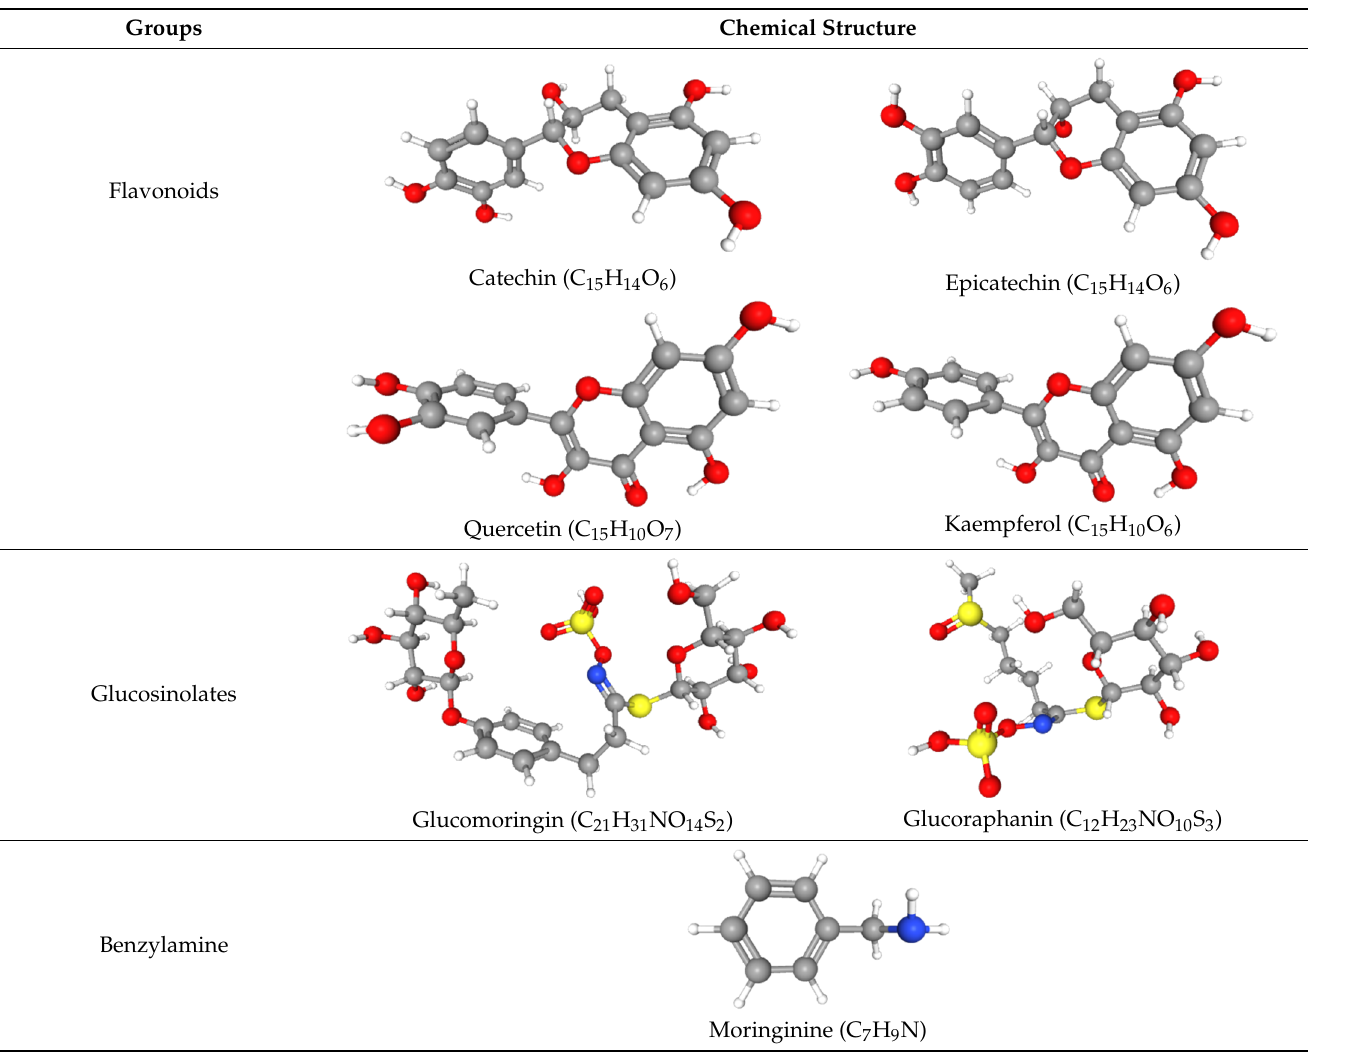
Table 2. Chemical structures of the selected bioactive compounds in MO. Groups